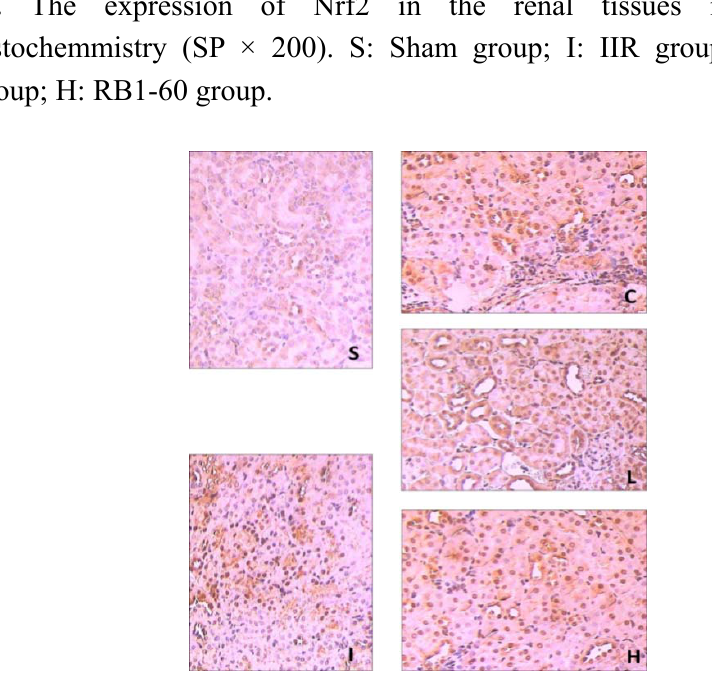
2. The expression of Nrf2 in the renal tissues in the groups by immunohistochemmistry (SP × 200). S: Sham group; I: IIR group; C: NS group; L: